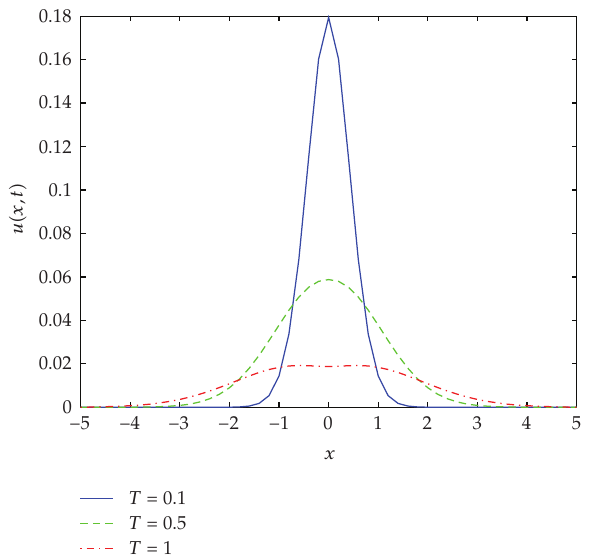
Figure 2: Numerical solutions for Example 5.2 with α (cid:7) 1 . 0 and μ (cid:7) 2 . 0 at di ff erent times T (cid:7) 0 . 1 , 0 . 5 , 1 . 0.